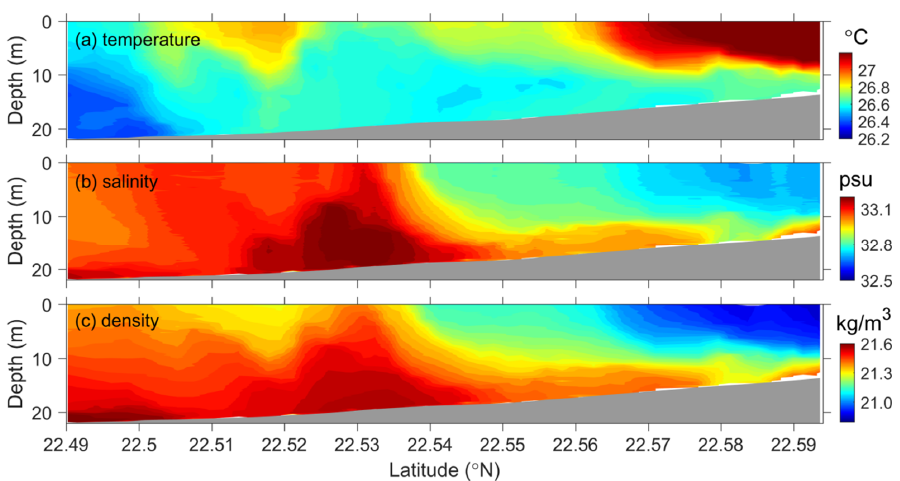
Figure 4. ( a ) Temperature, ( b ) salinity, and ( c ) density along transect S1 as measured by the YODA profiler.